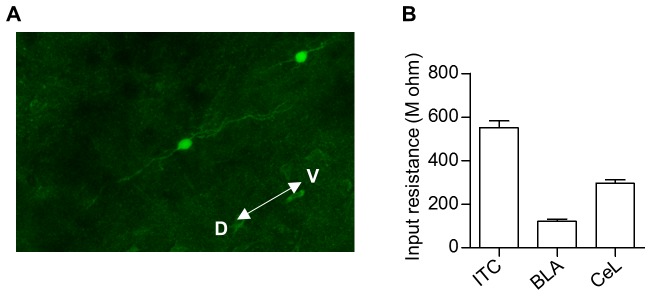
Identification of ITC neurons.(A) Representative image of ITC neurons dialyzed with Lucifer Yellow fluorescence dye. Twenty neurons out of the twenty-one neurons tested (95.2%) were determined to be ITC neurons from their morphology and electrophysiological characteristics. (B) The input resistance of ITC neurons (552.5 ± 30.0 MΩ, n = 20 cells), BLA neurons (121.4 ± 10.0 MΩ, n = 9) and CeL neurons (295.6 ± 16.3 MΩ, n = 10). The ITC neurons had significantly higher input resistance than those of the other groups (χ2 = 31.79, p<0.0001, p<0.05 for ITC versus the other groups, Kruskal-Wallis test followed by Dunn’s test). The input resistance was measured with potassium-based internal solution, which contains (in mM) 120 potassium gluconate, 0.2 EGTA, 10 HEPES, 5 NaCl, 1 MgCl2, 2 Mg-ATP and 0.3 Na-GTP with the pH adjusted to 7.2 with KOH and the osmolarity adjusted to approximately 297 mmol/kg with sucrose. BLA, basolateral amygdala, CeL, lateral part of central amygdala. We targeted a visually identifiable cluster of small neurons (diameter ≤ 10 µm) located between the BLA and the CeL. The ITC neurons were defined as cells showing a typical morphology with bipolar elongation of neurites alongside D-V axis and high input resistance (>450 MΩ) as previously described (Amano et al., 2010).